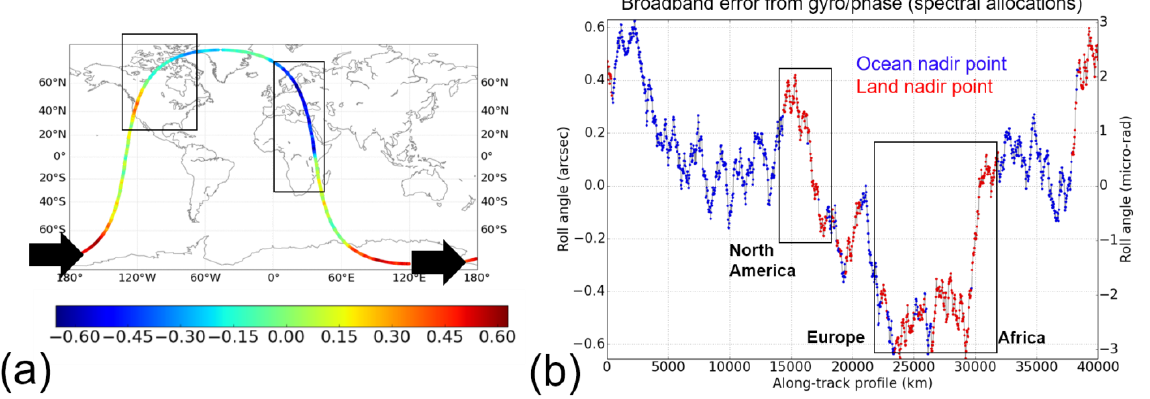
Figure 9. Overview of the uncalibrated roll (linear component of the error) for one arbitrary revolution. Panel ( a ) shows the geographical location and the roll error in arcsec. Panel ( b ) shows the uncalibrated error (linear component) for the “spectral allocation” scenario.